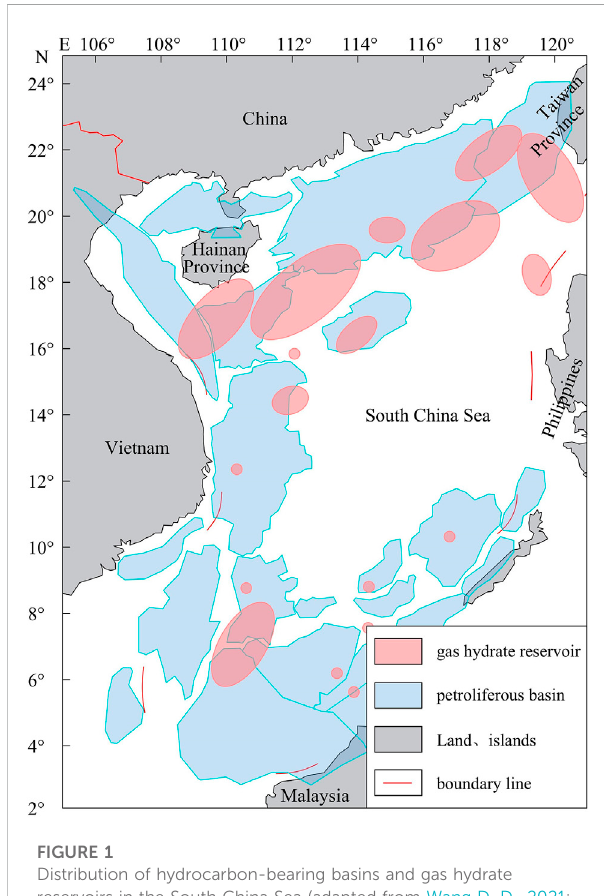
FIGURE 1 Distribution of hydrocarbon-bearing basins and gas hydrate reservoirs in the South China Sea (adapted from Wang D. D., 2021; Weng et al., 2013; Sun et al.,